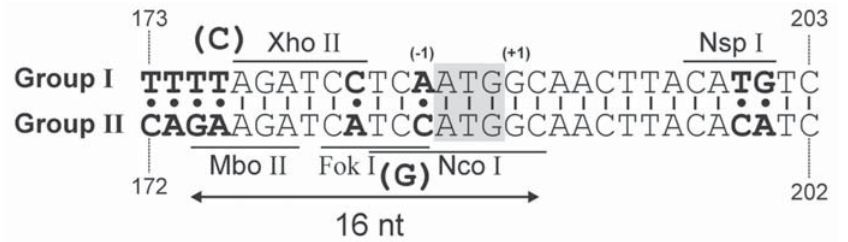
DNA.Fig. 2. The nucleotide sequences flanking the ATG in PVY groups I and II. Homologous nucleotides are indicated with a dash and mismatched ones with bold letters and dots - numbered downstream (-) and upstream (+) of the shaded ATG-translation initiation codon. The restriction endonuclease recognition sequences are under- and over- lined. Nucleotides in brackets varied among virus isolates. The nucleotides are numbered according to the refer- ence sequences of PVY O (group I) and PVY NTN (group